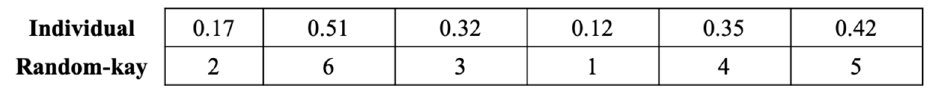
Figure 13. Mapping of a random key.